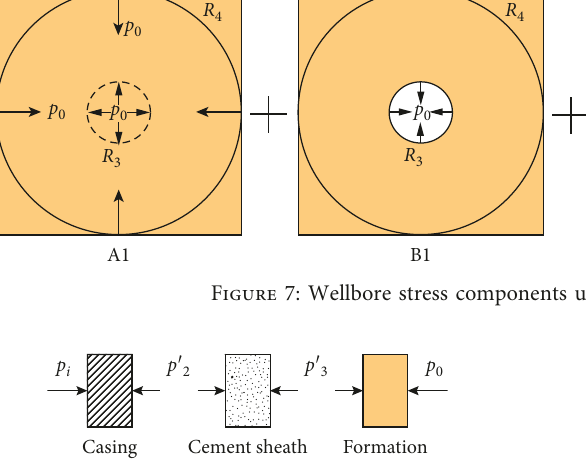
Figure 8: Interface pressures induced by uniform stress.